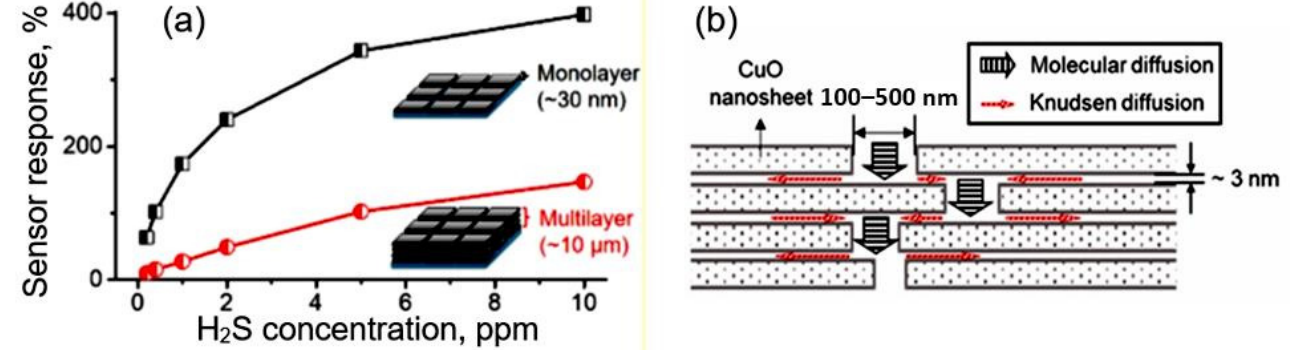
Figure 2. ( a ) Sensor response of monolayer ‐ and multilayer ‐ based sensors to H 2 S; ( b ) Model of a multilayer film with lamellar structure. Reproduced from [38]. Published 2019 by ACS as open access.